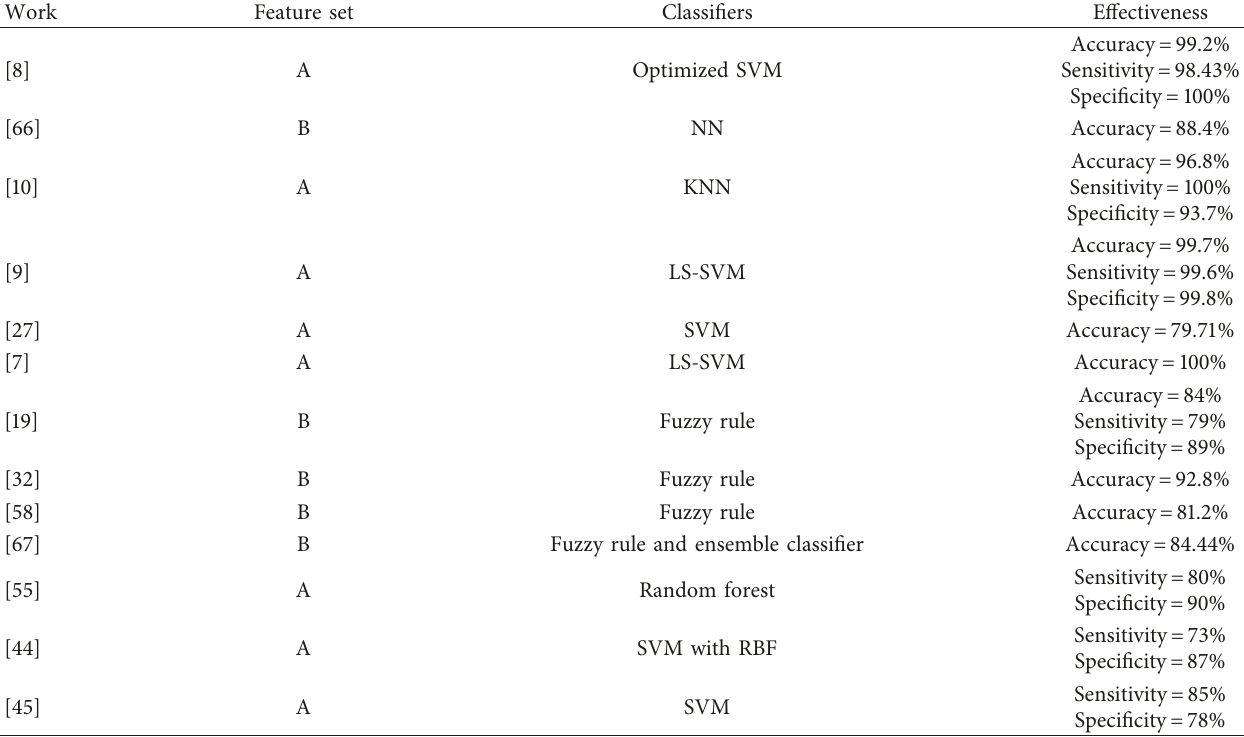
Table 3: Review of state-of-the-art classifiers and their effectiveness.